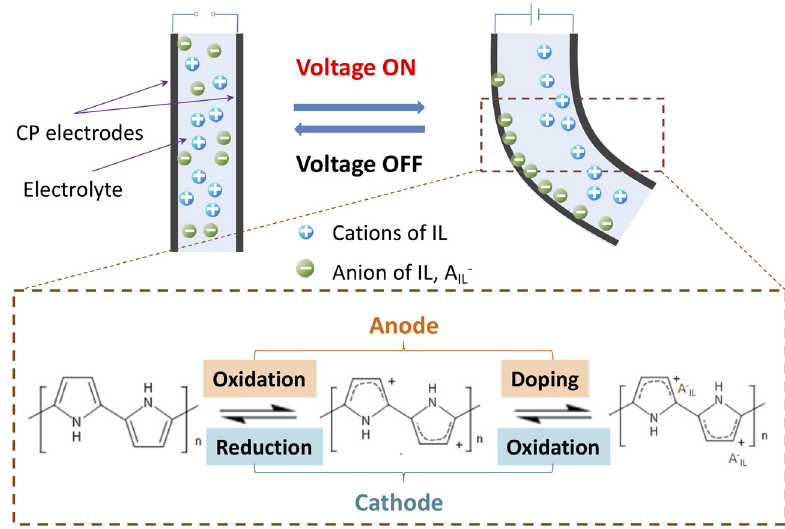
Figure 3: Actuation mechanism of CP